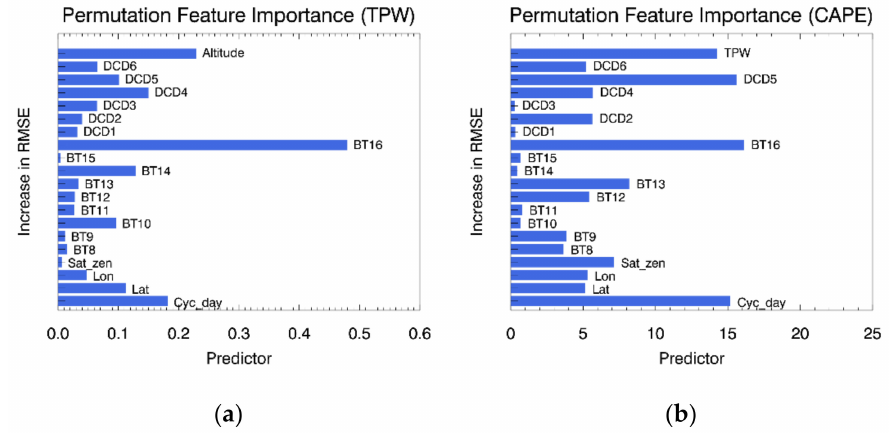
Figure 9. Analysis of final ( a ) TPW and ( b ) CAPE weights from static (ST) ANN model results for each input variable.